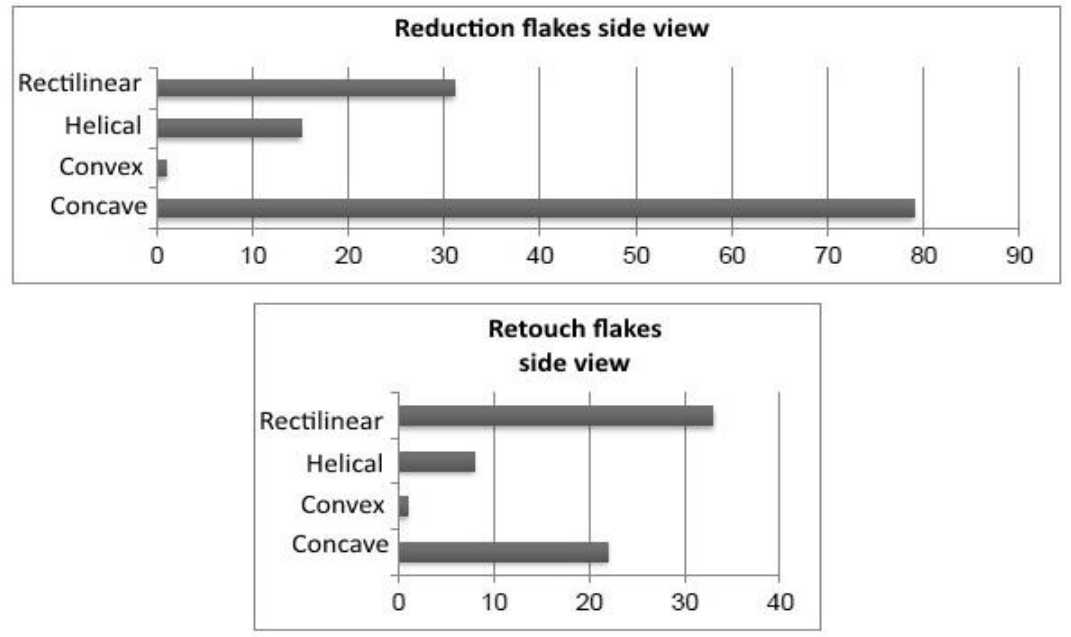
Figure 15. Reduction and retouch flakes side